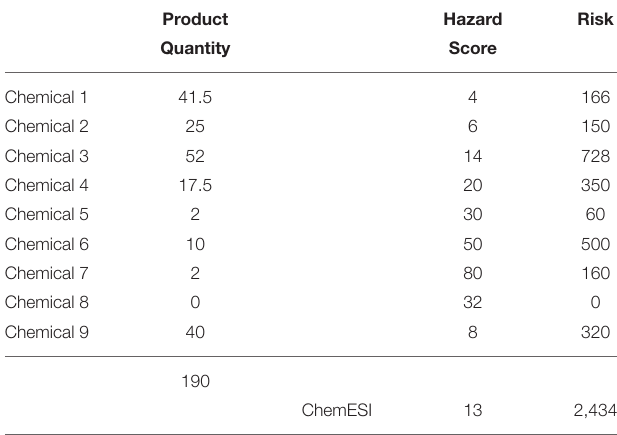
TABLE 6 | Chemical-based ChemESI following substitution of chemical 8 with chemical